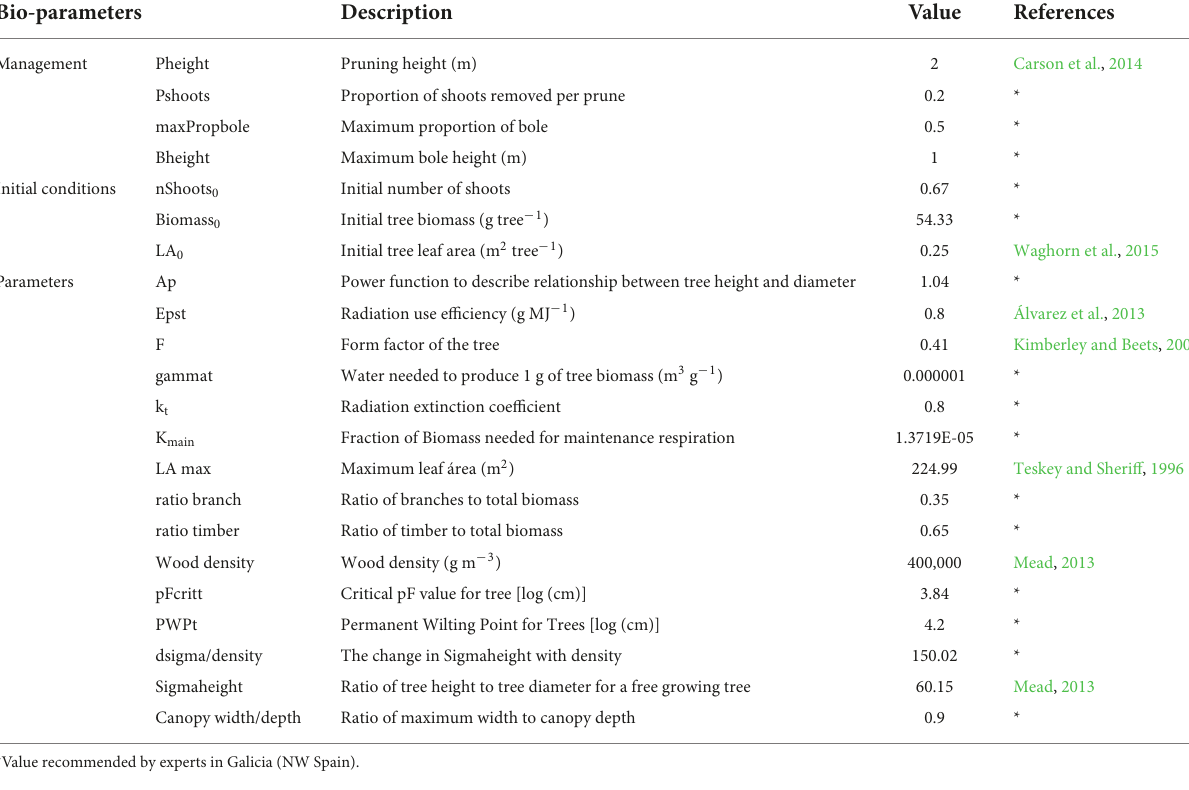
TABLE 1 Tree parameters used in the calibration and validation of the Yield-SAFE model for Pinus radiata. Bio-parameters Description Value